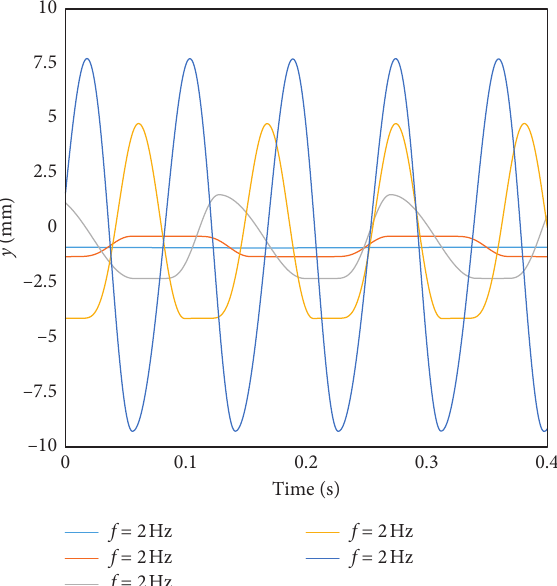
Figure 13: The influence of excitation amplitude on the response of the suspension system when excitation amplitude �